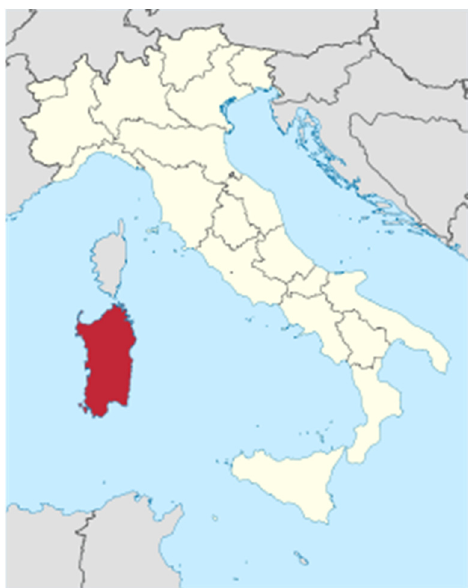
Figure 2. Location map of the island of Sardinia, Italy (‘Sardinia in Italy’ by TUBS 2011/Wikimedia Commons is released under CC BY-SA 3.0).